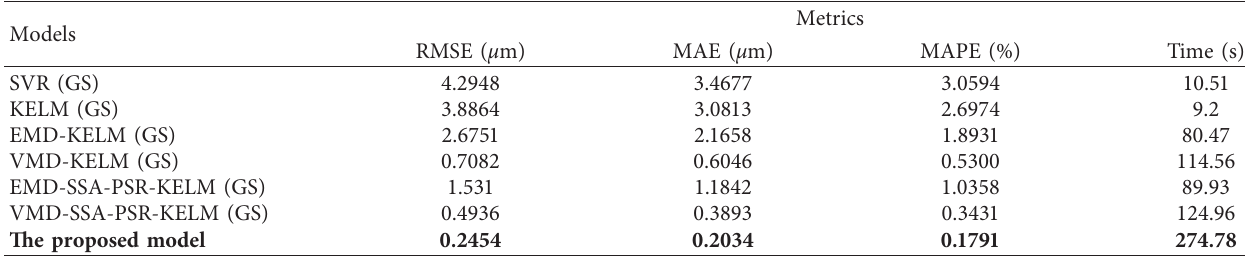
Table 4: Evaluation metrics of various forecasting models on the test